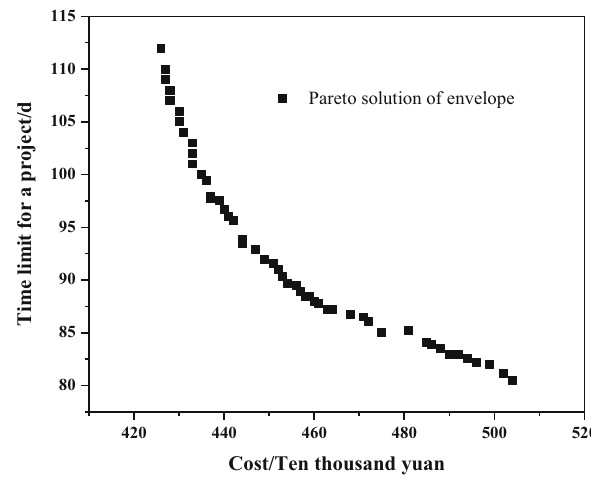
Figure 7: Pareto de - envelope